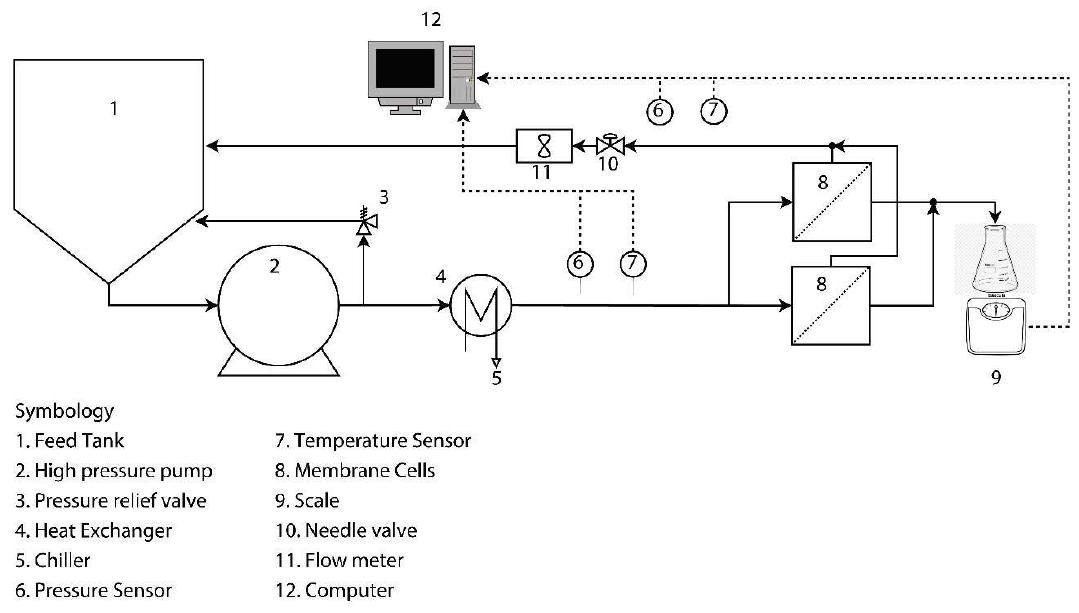
Figure2. Figure 2. Representative diagram of the experimental setup for accelerated biofouling of RO membranes.